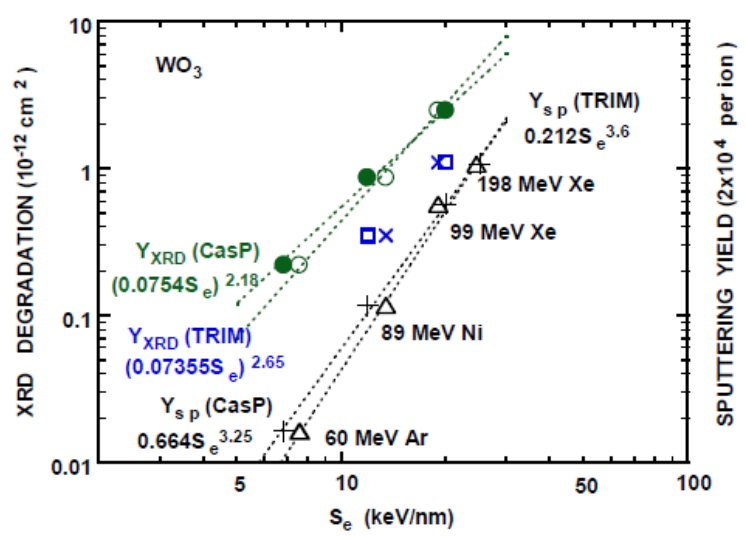
Figure 2. ( a ) XRD patterns of WO 3 films on MgO: unirradiated (x), 90 MeV Ni +10 ions at 0.48 × 10 12 cm −2 (o) and 90 MeV Ni ions through carbon foils (100 nm), i.e., equilibrium-charge incidence at 0.47 × 10 12 cm −2 (+). Film thickness is ~6.5 nm. ( b ) Ratio of XRD intensity degradation by irradiation under 90 MeV Ni +10 incidence over that 90 MeV Ni ions with the equilibrium charge (o) and ratio of XRD intensity degradation by irradiation under 100 MeV Xe +14 incidence over that 100 MeV Xe ions with the equilibrium charge (∆). Dot and dashed lines are guides for eyes. Experimental XRD data are from [49].